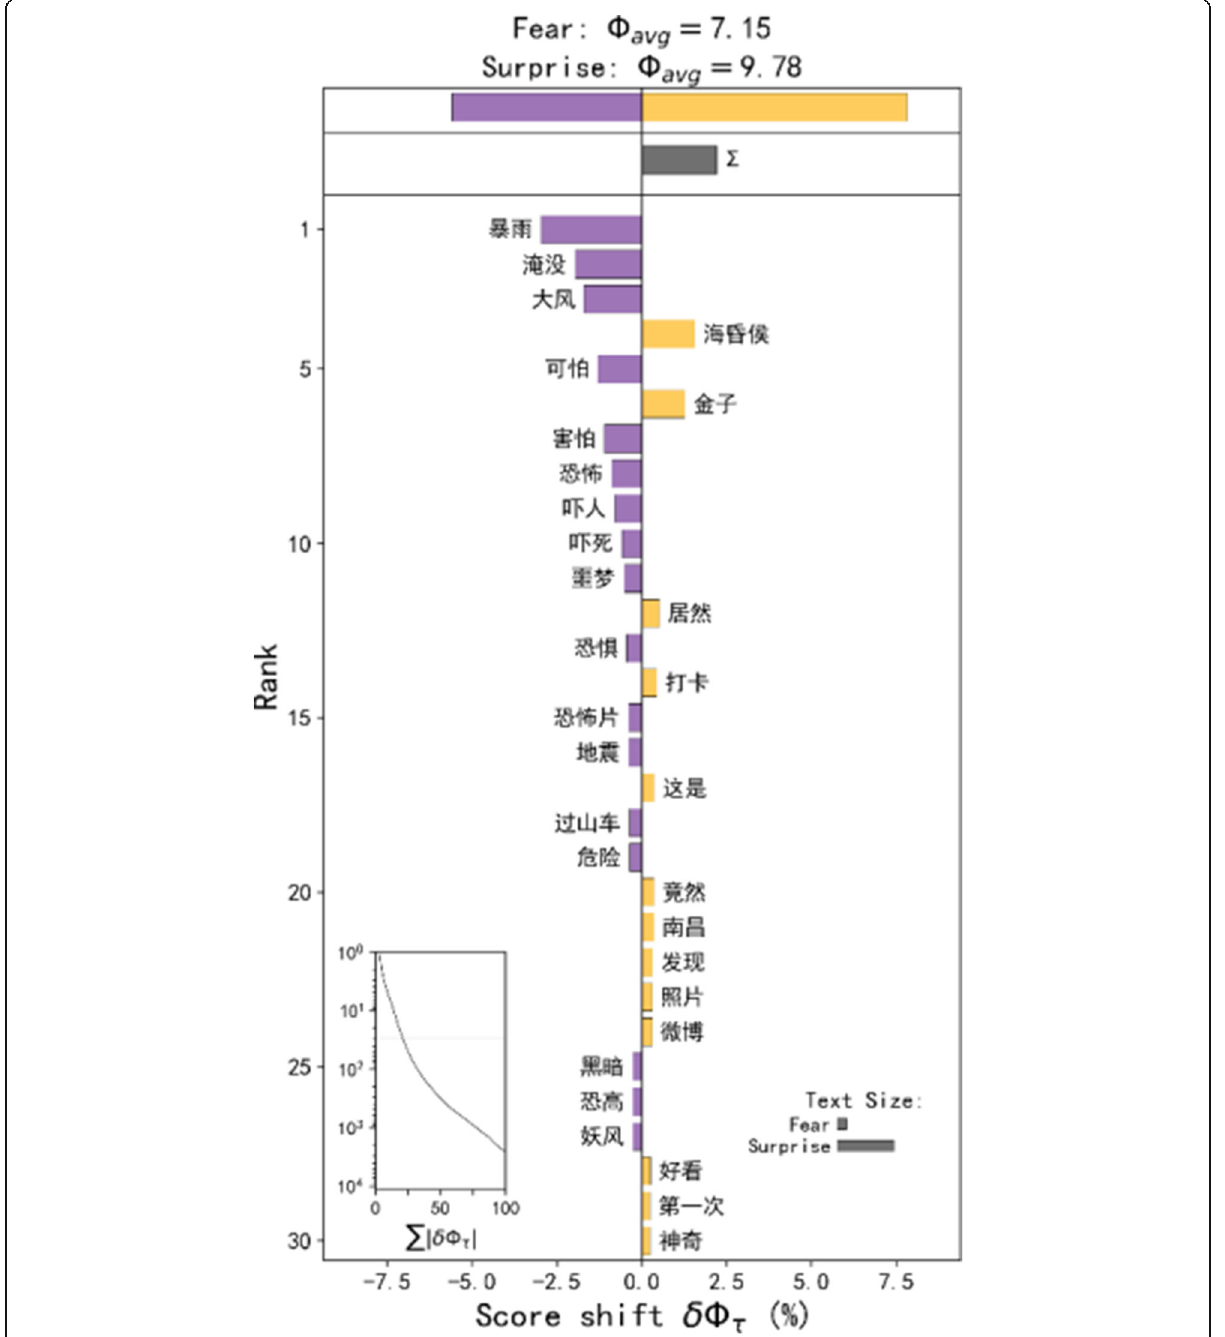
Fig. 7 Word shift graphs of the Weibos in the fear and surprise emotion hot